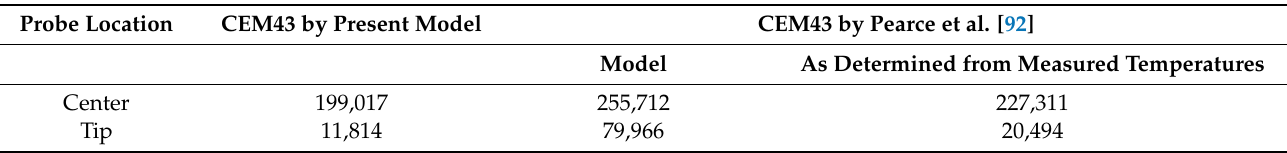
Table 5. Comparison of the CEM43 values of our model, for Case A, with the model and the experimental measurements by Pearce et al.